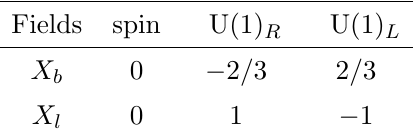
Table 3 . The U(1) U(1) charge assignment of the extra scalars. They are not charged under L (cid:2) R SU(3) SU(2) SU(2) c (cid:2) L (cid:2) R